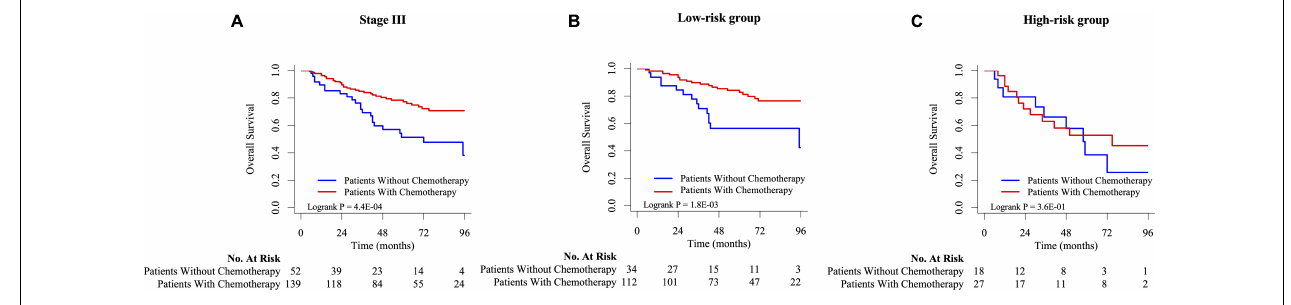
FIGURE 5 | The K-M survival analysis between chemotherapy and non-chemotherapy group on stage III (A) , low-risk (B) , and high-risk (C) CRC patients in GSE39582.